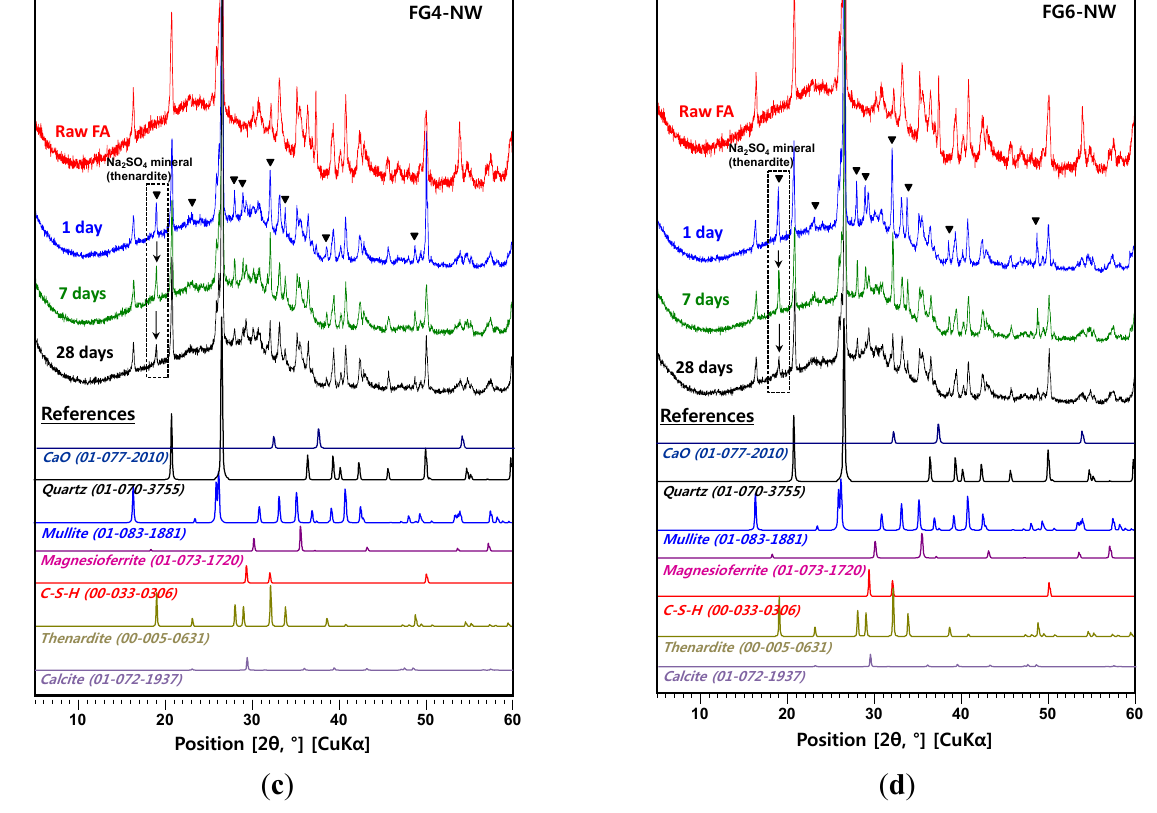
Figure 4. XRD patterns of samples by curing time. The simulated reference patterns (e.g., quartz, mullite) are scaled to have the same signal intensity observed in the one-day cured sample. The numbers in ( ) indicate ICDD PDF numbers. ● : peak positions of CaO. ▼ : peak positions of thenardite. Raw fly ash is labeled as Raw FA. ( a ) F-NW sample; ( b ) FG2-NW sample; ( c ) FG4-NW sample; ( d ) FG6-NW sample.